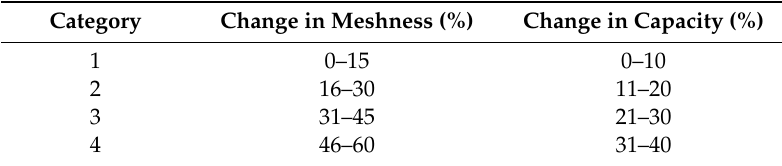
Table 3. Classification of meshness and total sewer storage